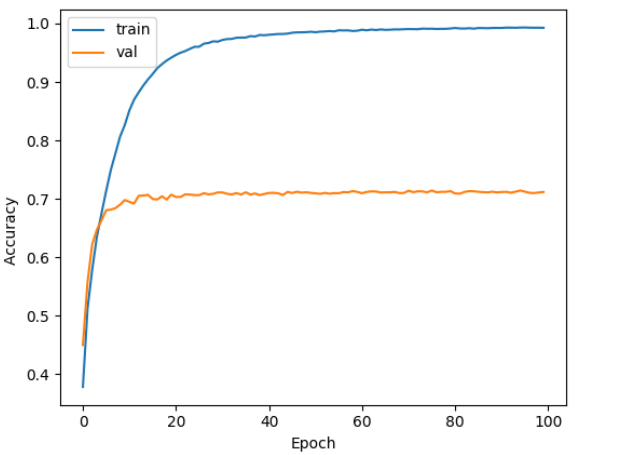
Figure 14. The accuracy of DEMON-AV and LENET (70%).